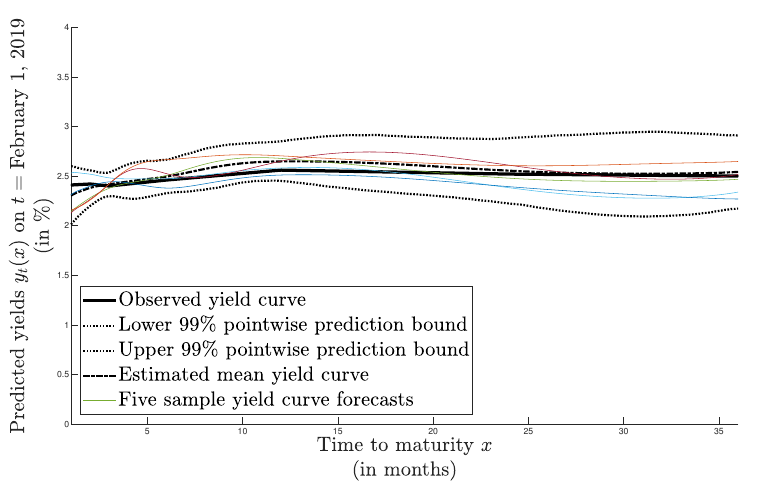
Figure 4. Predicting the yield rates on 1 February 2019 based on 2018 historical data. The left panel of Figure 5 displays the historical yield curve rates for January 2019 (22 business days), while the right panel gives the estimated mean yield curve rate for the same time window based on 10,000 replications. We conjecture that the slight overestima- tion of the yield curve for large maturities may be related with the non-decreasing behavior of the long rates (see Section 4.1).